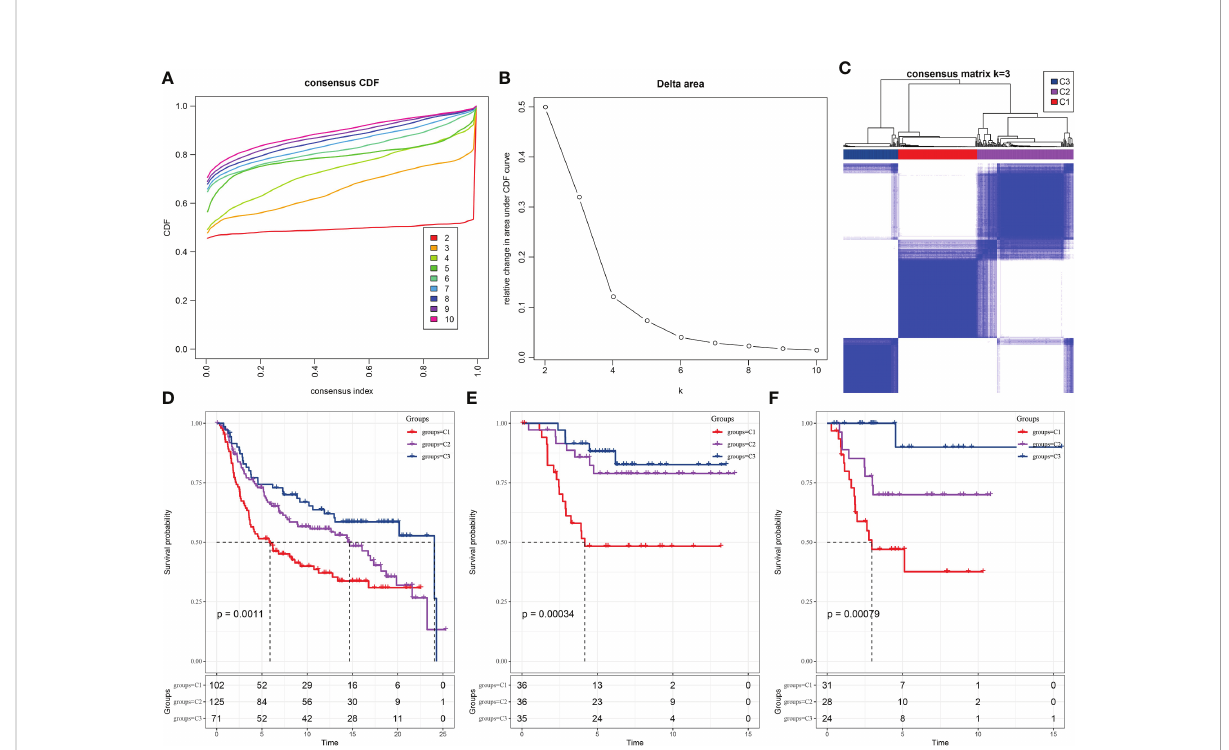
FIGURE 2 Recognition of three TNBC subtypes based on LR pairs. (A) Consensus clustering cumulative distribution function (CDF) for k = 2 – 9. (B) Delta area curve of consensus clustering for samples in METARIC. (C) Heatmap of sample clustering at consensus k = 3. (D) Kaplan-Meier analysis of OS among three subtypes in METARIC dataset. (E) The Kaplan-Meier curve of OS of three molecular subtypes formed in GSE58812 data set. (F) Differences of three subtypes in GSE21653 dataset on